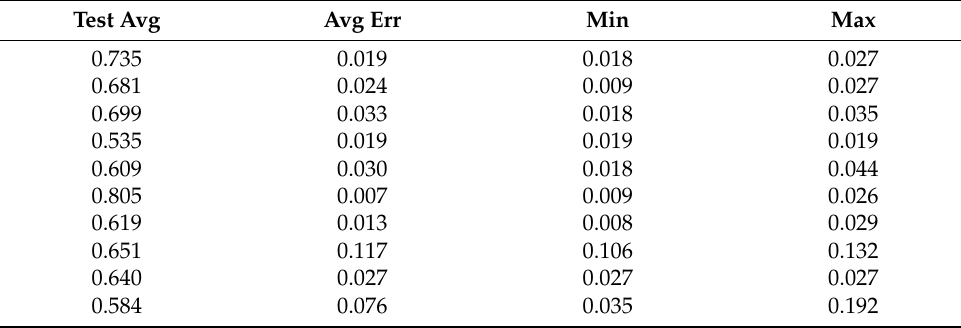
Table A129. Set 2, trials 31–40 data (single 0.5 PR